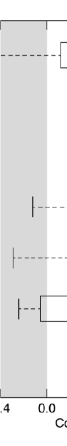
Figure 4. Inter-radii correlations at different tree heights. Box plots as in Figure 3, but for correlations among radii A–F. Value range r < 0.0 highlighted in grey.